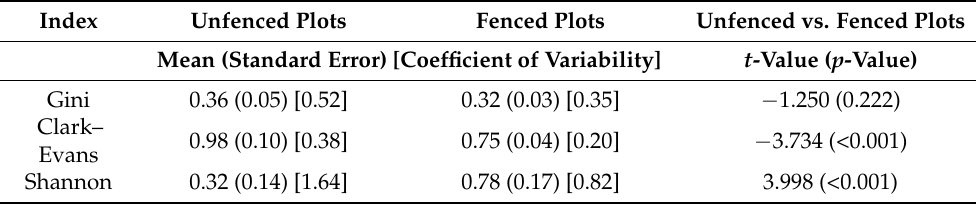
Table 5. A comparison of mean values, standard errors, and coefficients of variability for Gini, Clark–Evans, and Shannon index between the plots within unfenced (open to herbivores) and fenced (herbivore exclusion) plots. Gini H index (indicates height evenness in stand—the higher value the higher evenness, Clark–Evans index (indicates space distribution of trees in stand—the higher value the more regular tree allocation), and Shannon diversity index (indicates species diversity in stand—the higher value the richer species composition) between unfenced and fenced plots. Statistical differences were proved by Student’s t